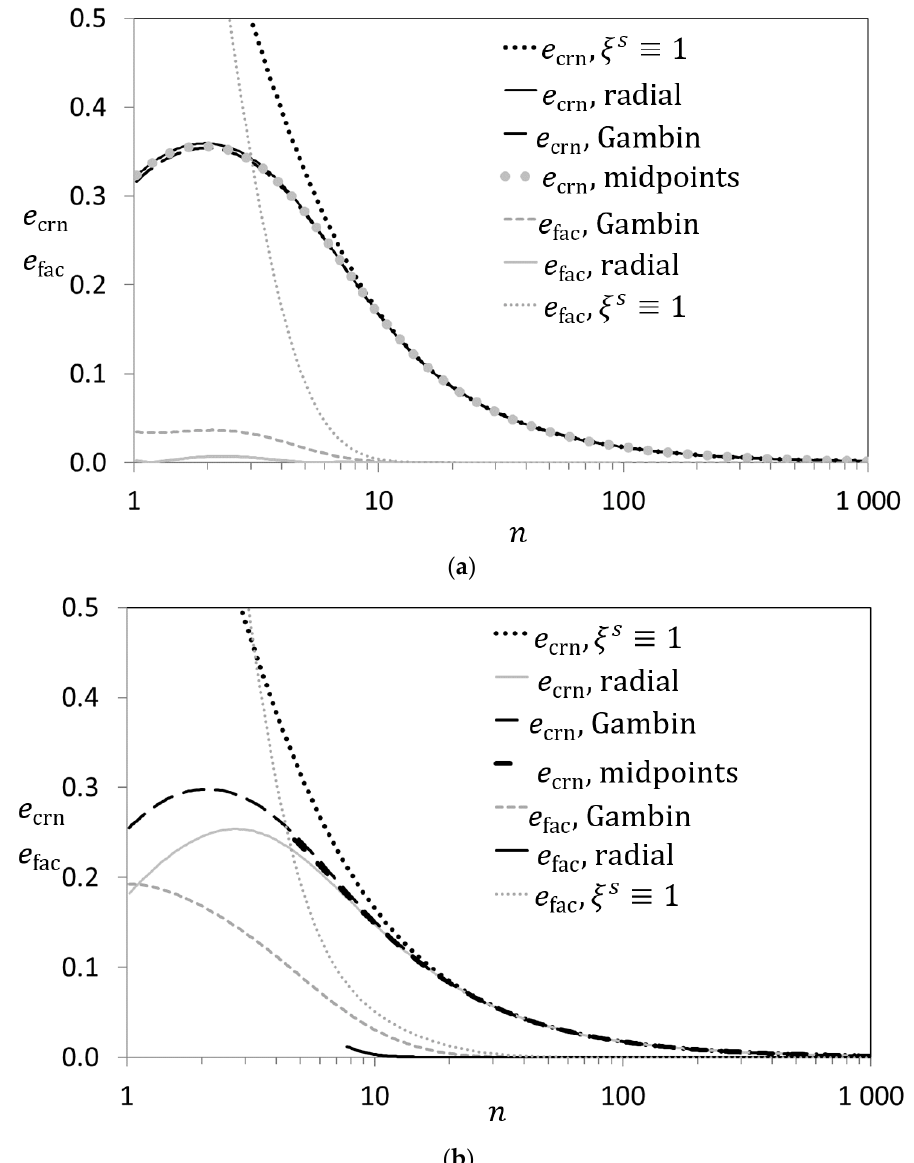
Figure 3. The fitted coefficients of the yield surface as functions of the exponent 𝑛 , for the case of fcc with ( a ) octahedral (cid:4668)111(cid:4669)⟨1(cid:4636)10⟩ and ( b ) additional nonoctahedral (cid:4668)001(cid:4669)⟨1(cid:4636)10⟩ slip systems, fitted to facet midpoints, by the regularization proposed by Gambin, and fitted radially to the facets. ( a ) 𝜏 (cid:3030)(cid:4668)(cid:2868)(cid:2868)(cid:2869)(cid:4669)⟨(cid:2869)(cid:4636)(cid:2869)(cid:2868)⟩ = 𝜏 (cid:3030)(cid:4668)(cid:2869)(cid:2869)(cid:2869)(cid:4669)⟨(cid:2869)(cid:4636)(cid:2869)(cid:2868)⟩ and ( b ) 𝜏 (cid:3030)(cid:4668)(cid:2868)(cid:2868)(cid:2869)(cid:4669)⟨(cid:2869)(cid:4636)(cid:2869)(cid:2868)⟩ = 1.5𝜏 (cid:3030)(cid:4668)(cid:2869)(cid:2869)(cid:2869)(cid:4669)⟨(cid:2869)(cid:4636)(cid:2869)(cid:2868)⟩ .